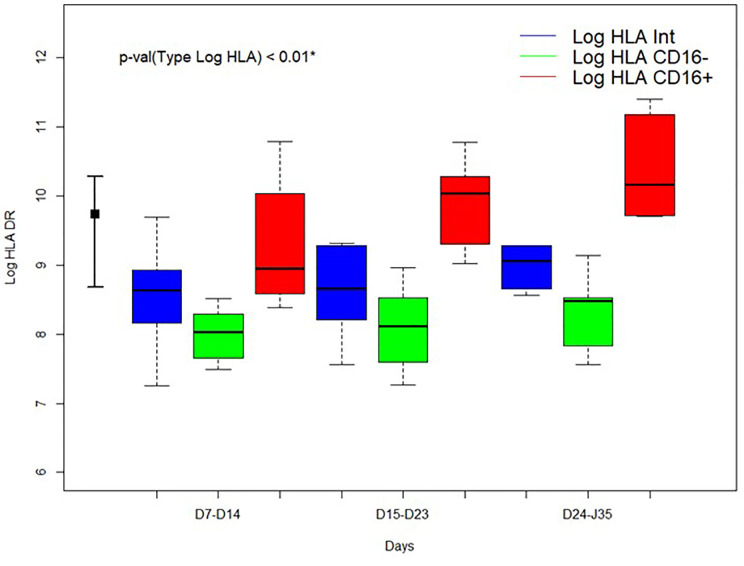
Time evolution of HLA-DR expression according to the delay from the onset of symptoms for 3 monocyte subtypes. Blue: intermediate (CD14++CD16+) monocytes; green: classical (CD14++CD16-) monocytes; red: non-classical (CD14+CD16++) monocytes. HLA-DR: Human Leucocyte Antigen-DR expressed as events per cell (AB/C). *Kruskall-Wallis test comparing the median values of HLA-DR expression of monocytes subtypes during all stay. Log: Log10. At left normal expected values for HLA-DR expression in total monocytes.